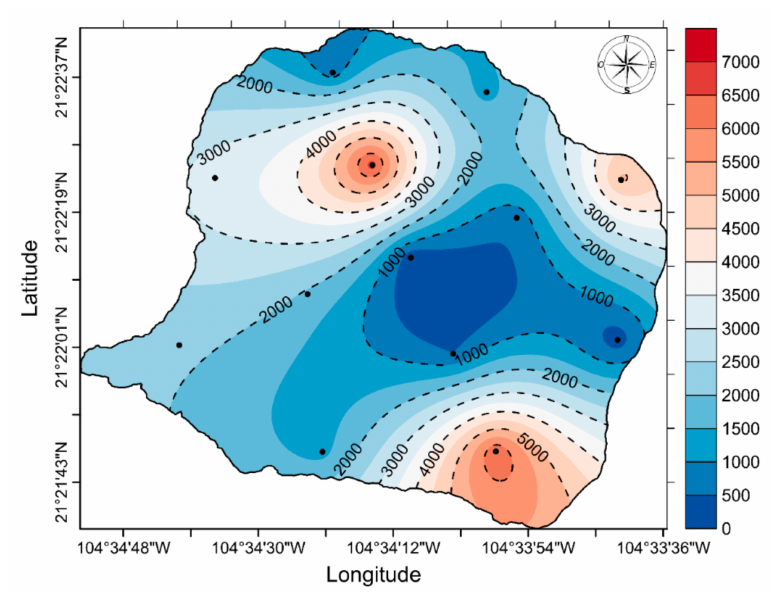
Figure 5. Total microcystin distribution ( µ g / kg of dry weight) in algae scums in Santa Mar í a del Oro lake during March 2015.